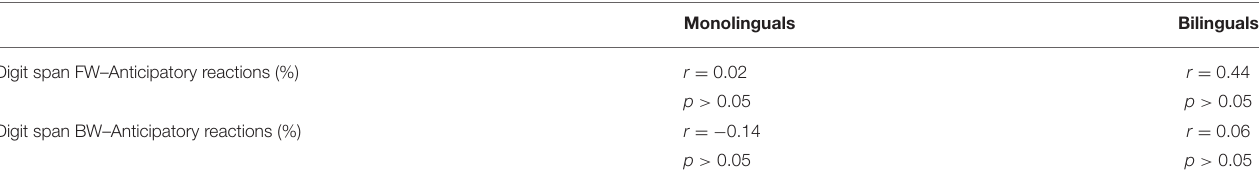
TABLE 8 | Results of correlation analyses between working memory (forward [FW] and backward [BW] digit span) and predictive processing (in percentage of anticipatory reactions).